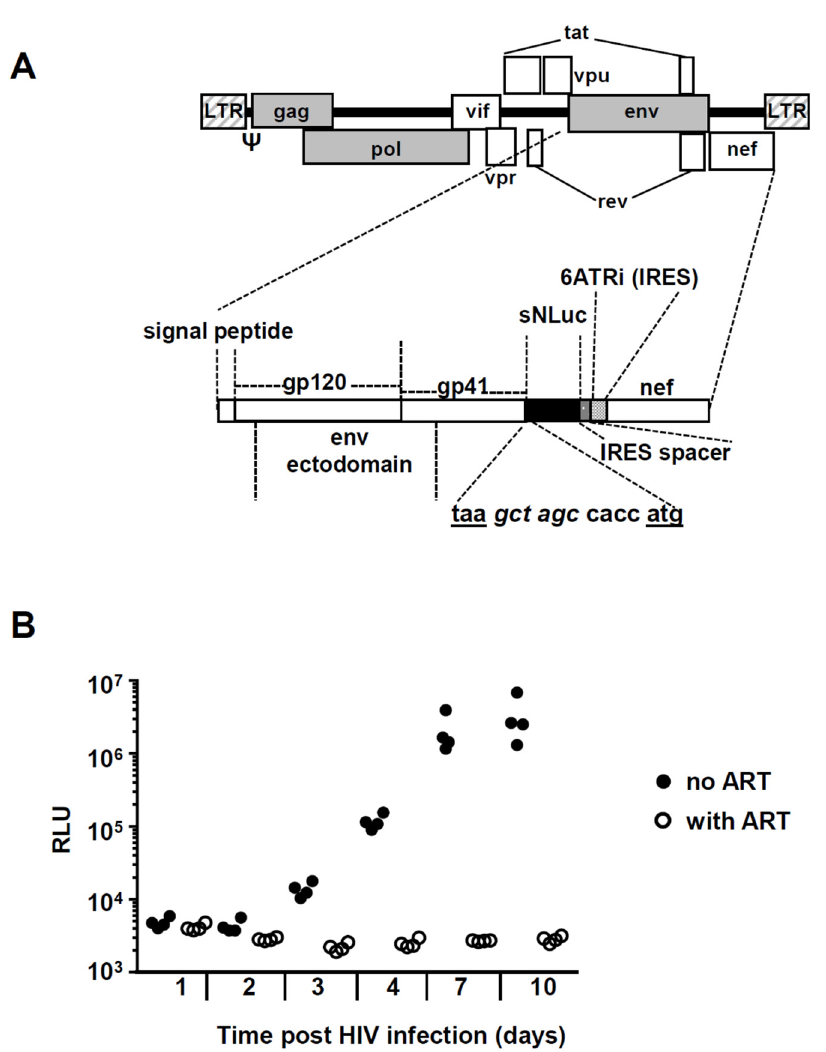
Figure 2. Experimental strategy to quantify in vitro HIV-1 replication in PBMC. ( A ) Simplified schema of the replication-competent R5-tropic HIV-1 reporter virus vNL-sNLuc.6ATRi-B-Bal.ecto. The vector was based on the NL-Bal.Env.ecto-derived molecular clone of HIV-1 expressing Renilla luciferase previously generated by Ochsenbauer and Astronomo et al. [50,51]. The reporter gene (indicated as the black area) is a secreted form of nanoluciferase (encoded by the reporter gene sNLuc ); nef expression is regulated by an internal ribosome entry site (IRES). The sNLuc.IRES cassette was inserted between the NL.Bal.ecto env and nef genes; 6ATRi is a truncation (“TR”) fragment derived from the encephalomyocarditis virus (EMCV) IRES and contains the “wild type” (A) 6 (i.e., “6A”) bifurcation loop. The nucleotide sequence shows the junction between the stop codon of env (taa) and the start codon (atg) of sNLuc, and contains a Nhe I restriction site (gct agc) and the translation initiation Kozak sequence (ccacc). The construct contains a 26 nt “IRES spacer” between the sNLuc gene and the IRES element, as previously described [51]. ( B ) Example of an in vitro HIV-1 infection experiment. PBMC were infected at MOI 0.2 in the presence (empty circles) or absence (full circles) of 1 µM raltegravir and 1 µM efavirenz. Aliquots from supernatants were taken at the indicated time points ( x -axis) and nanoluciferase activity was determined using the Promega Nano-Glo© kit ( y -axis, RLU: relative light units).